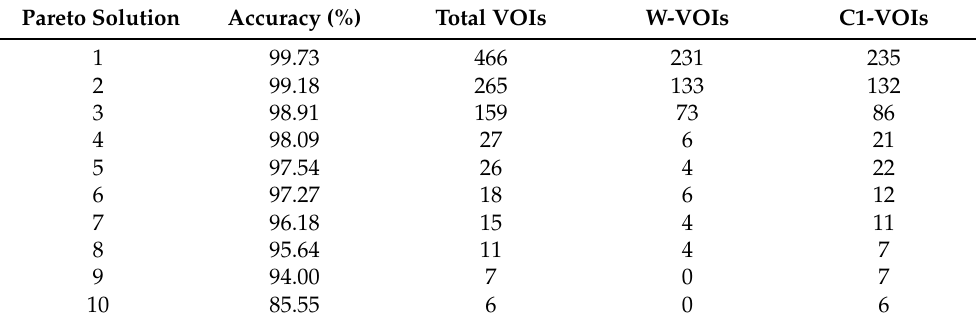
Table 4. Pareto front for VOI optimization. Training